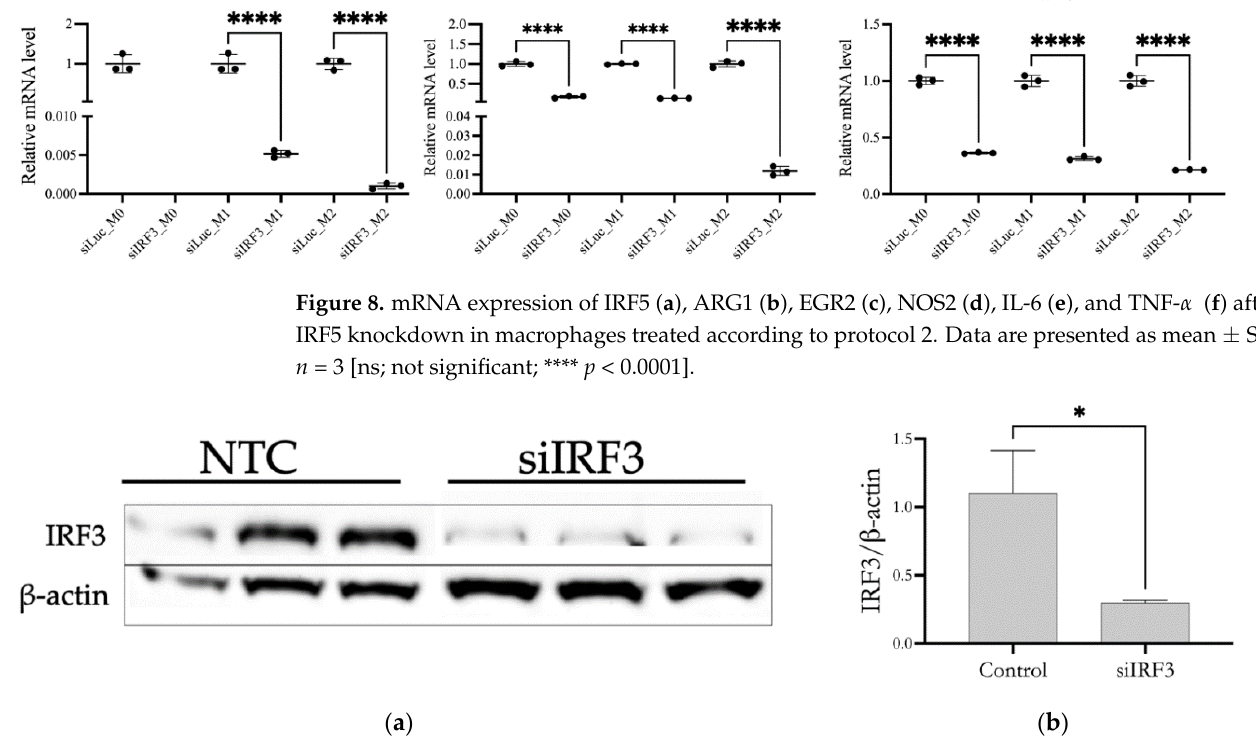
Figure 9. Western blot analysis of IRF3 expression in nonpolarized BMDM after siRNA-mediated knockdown of IRF3 for three days measured in triplicates ( a ). Bar graph ( b ) shows IRF3 protein quantity relative to expression of β -actin. Each bar represents the mean ± S.D. of three replicates. * p < 0.05. NTC indicates non-transfected control.